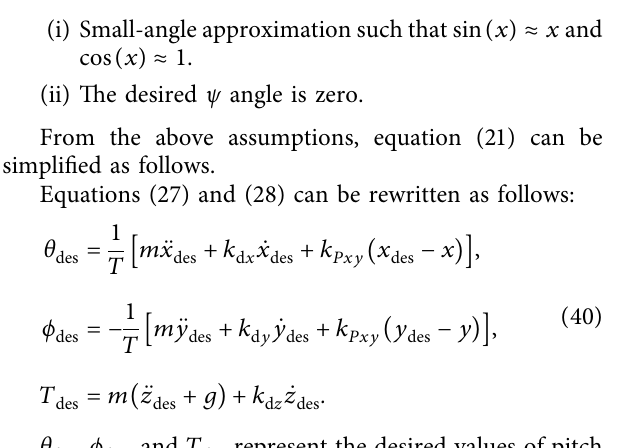
Figure 7: The angular velocities of the rotors as a function of time for implemented PD controller for attitude